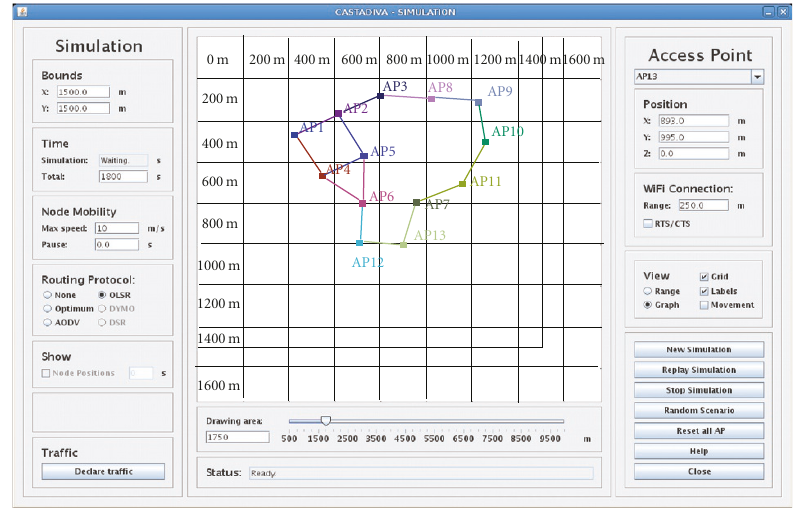
Figure 2: Scenario definition with Castadiva .